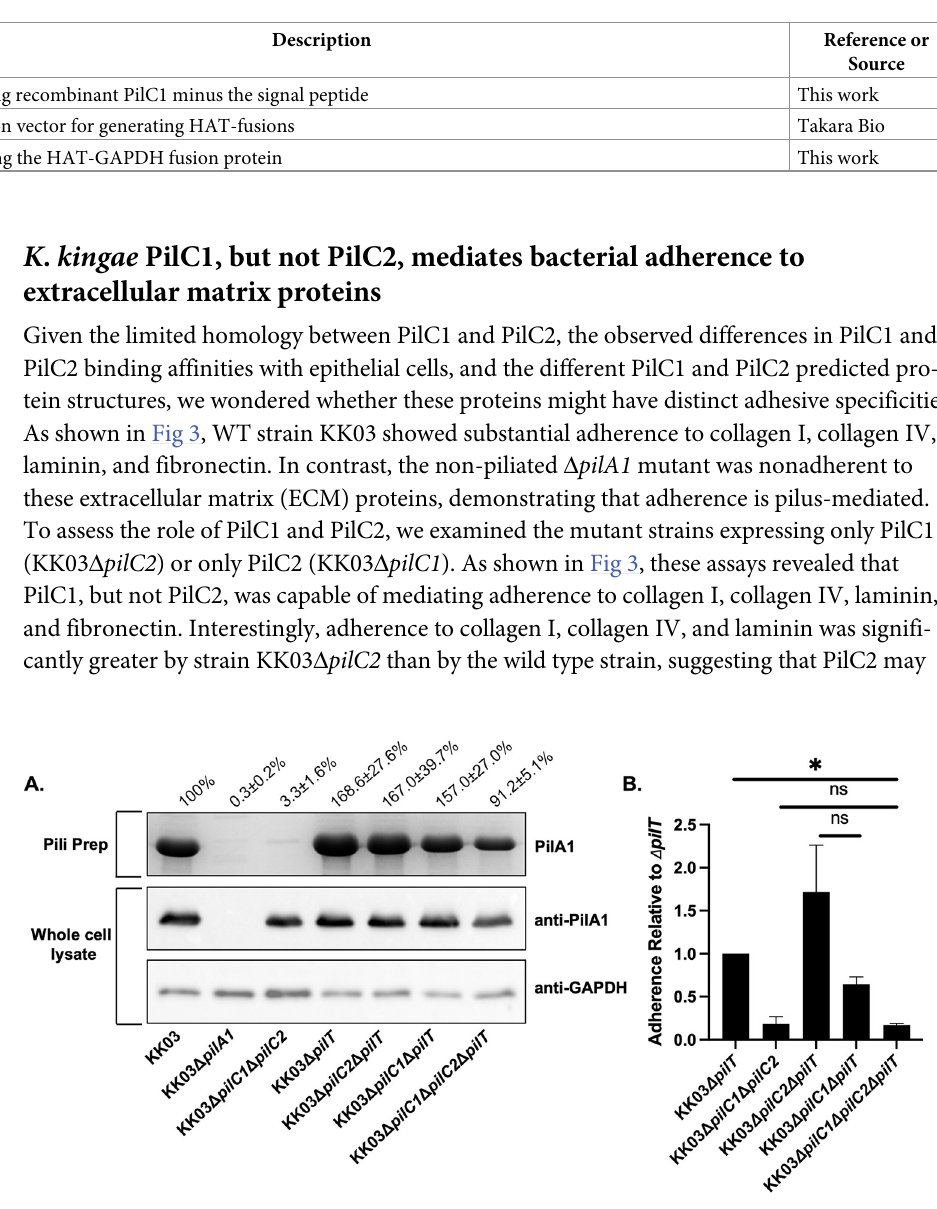
Fig 1. Deletion of retraction ATPase PilT restores surface piliation but not adherence in a K . kingae Δ pilC1 Δ pilC2 mutant strain. (A) Sheared pili fractions of strains KK03, KK03 Δ pilA1 , KK03 Δ pilC1 Δ pilC2 ,KK03 Δ pilT , KK03 Δ pilC2 Δ pilT ,KK03 Δ pilC1 Δ pilT ,and KK03 Δ pilC1 Δ pilC2 Δ pilT were boiled and separated using SDS-PAGE. For pili preps, the PilA1 pilin monomer band was stained with Coomassie blue. For whole cell lysates, the PilA1 pilin monomer band was detected by Western blot analysis using polyclonal antiserum GP65 [52] to PilA1. GAPDH was detected by Western blot analysis to control for total protein using polyclonal antiserum CHP-GP22. The values above the gel and blot images are densitometry measurements of the PilA1 band from the sheared pilus preparations (pili prep) gel that were normalized to the α -GAPDH band intensities and are expressed as a percentage of the band intensity of the wild type strain KK03. The densitometry values are listed ± standard error of the mean from three biological replicates, and representative gel and blot images are shown. (B) Strains KK03 Δ pilC1 Δ pilC2 ,KK03 Δ pilT , KK03 Δ pilC2 Δ pilT ,KK03 Δ pilC1 Δ pilT ,and KK03 Δ pilC1 Δ pilC2 Δ pilT were added to monolayers of Chang epithelial cells of HeLa origin and evaluated for adherence. Percent adherence was calculated based on the ratio of recovered bacteria to the inoculum. Error bars represent standard error of the mean, n = 3. � indicates significance of P < 0.05 as determined by a one-way ANOVA using Bonferroni correction for multiple comparisons. ns indicates no significance.